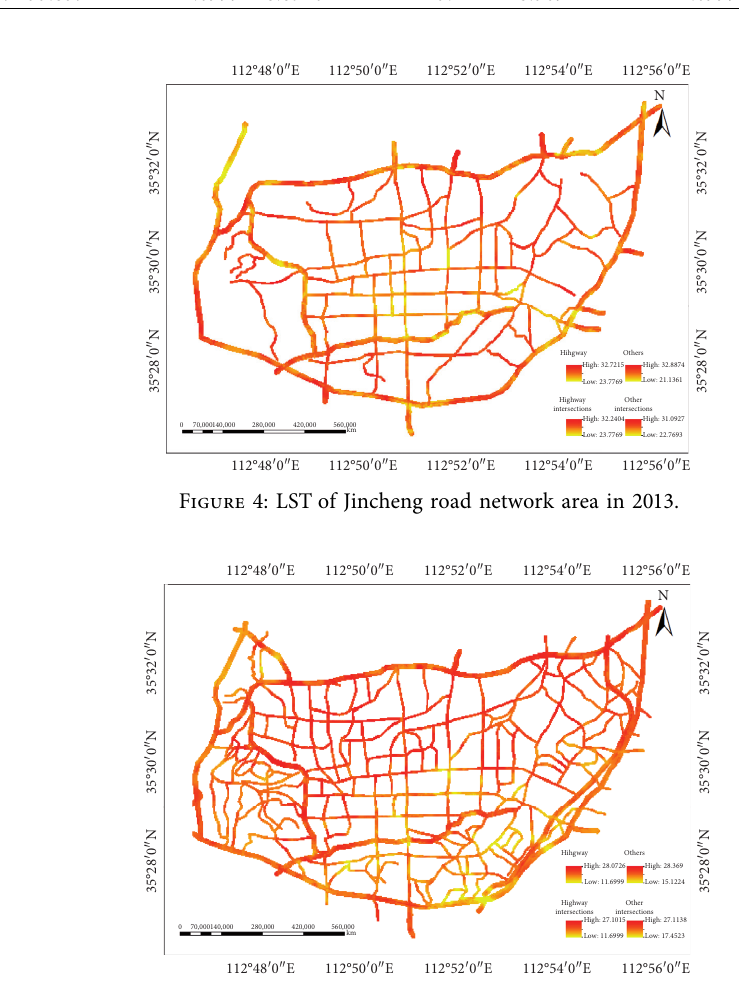
Figure 5: LST of Jincheng road network area in 2018. Table 3: Increased mileage of high and low LST change of other